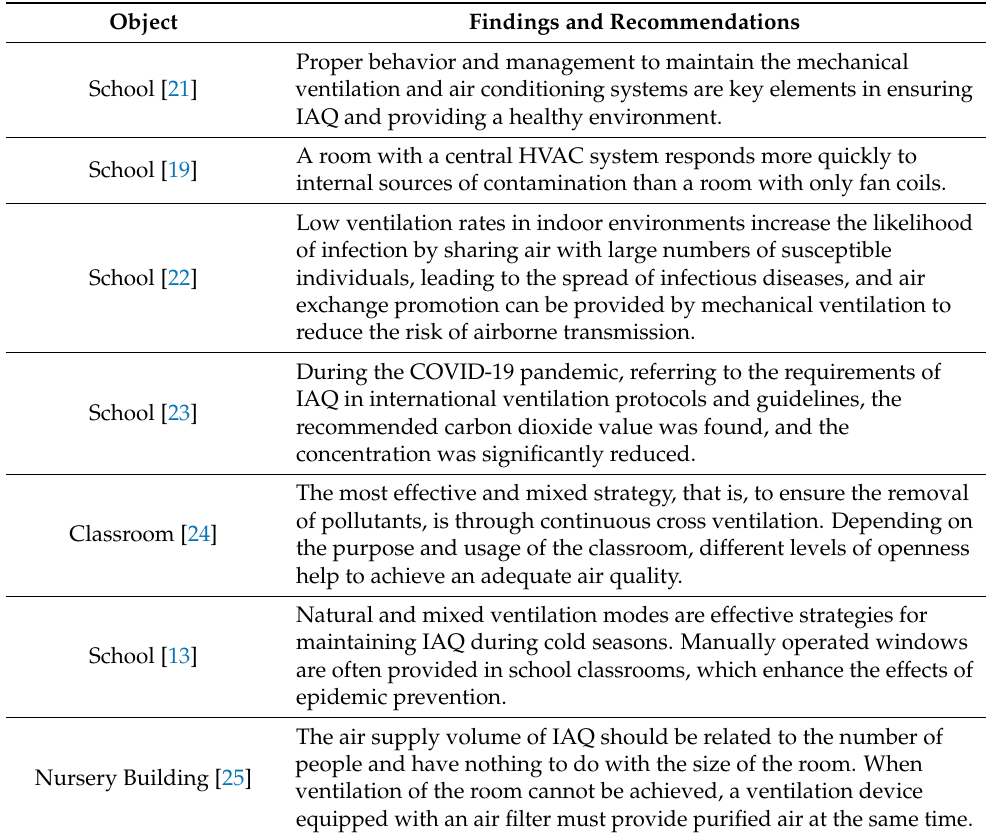
Table 2. Findings and recommendations from empirical research on IAQ and